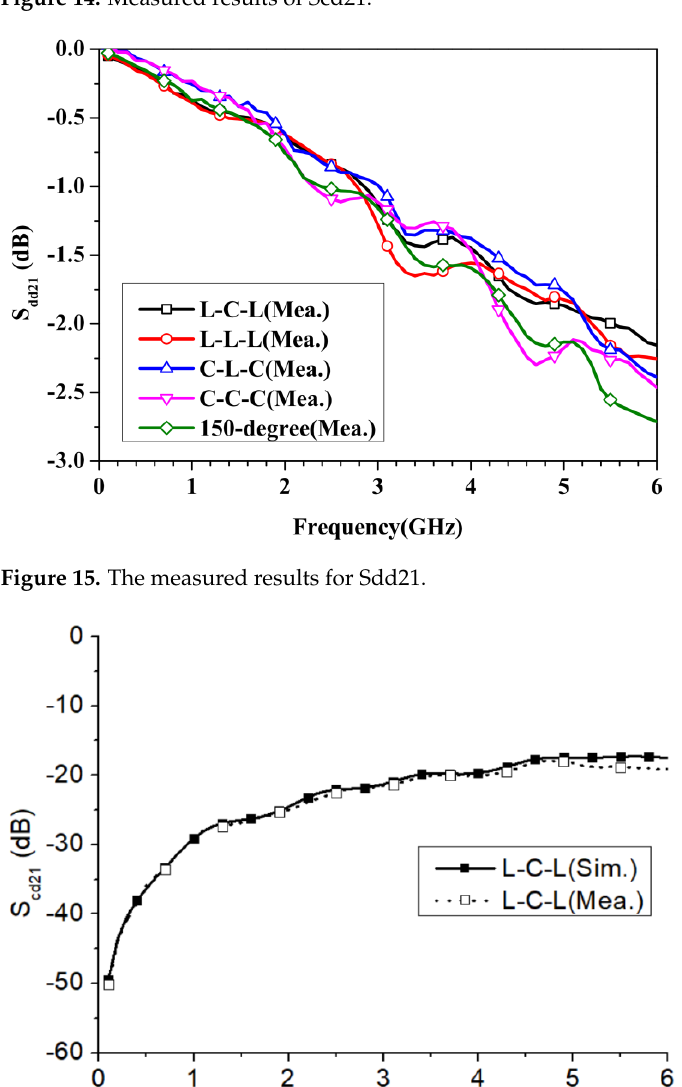
Figure 14. Measured results of Scd21.